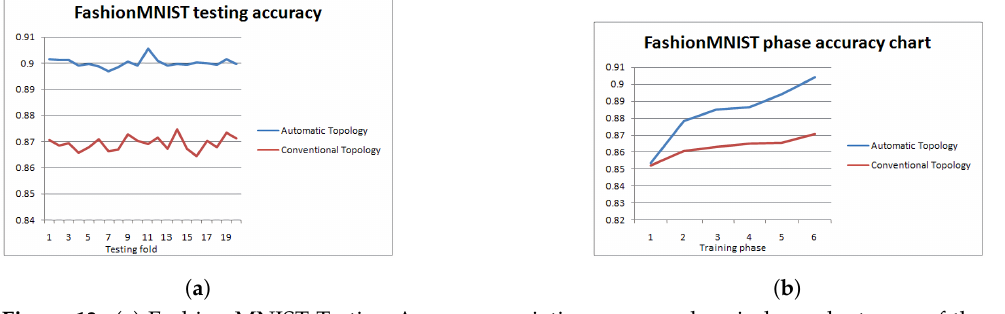
Figure 13. ( a ) Fashion MNIST Testing Accuracy variation over random independent runs of the optimised and the conventional NN; ( b ) Fashion MNIST Accuracy every five-epoch training (1 phase) for the optimised and the conventional